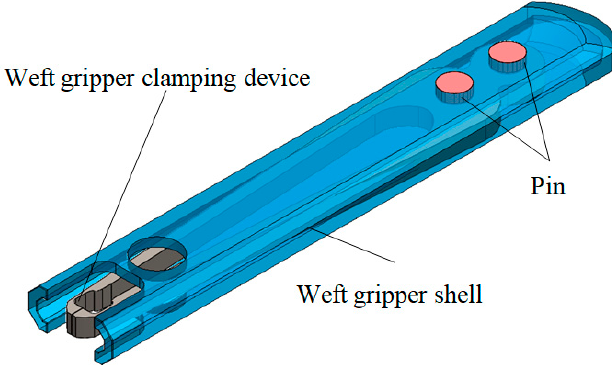
Figure 4. The structure diagram of the weft clamp assembly.